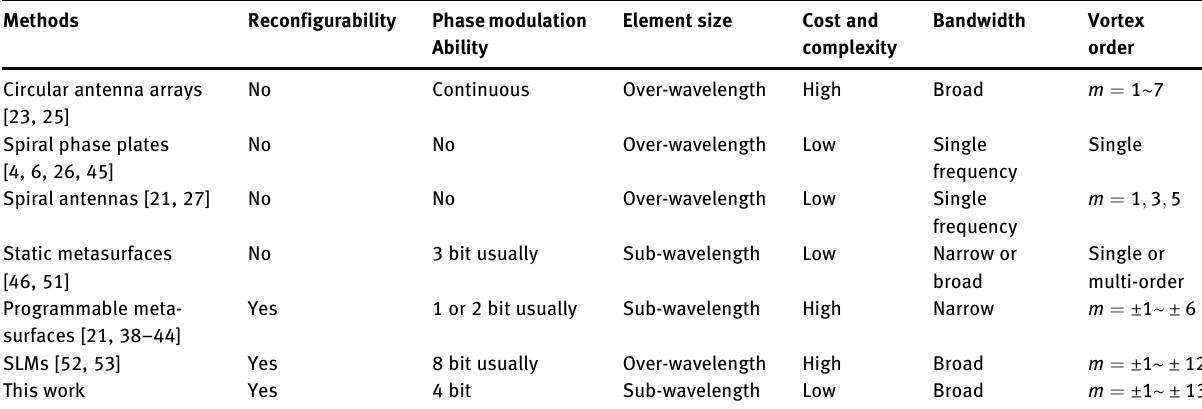
Table  : Performance comparison between this work and previous methods for the generation of high-order vortex beams. Methods Circular antenna